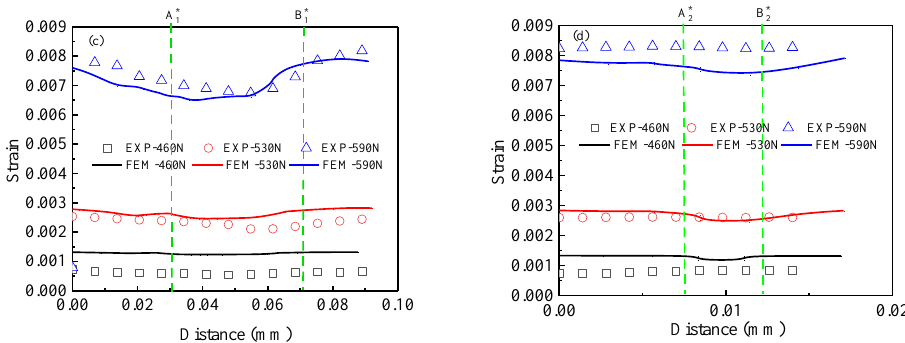
Figure 8. Strain distribution along different paths in the test: ( a ) path Line1 in the 1# region, ( b ) path Line2 in the 1# region, ( c ) path Line1* in the 2# region, ( d ) path Line2* in the 2# region.